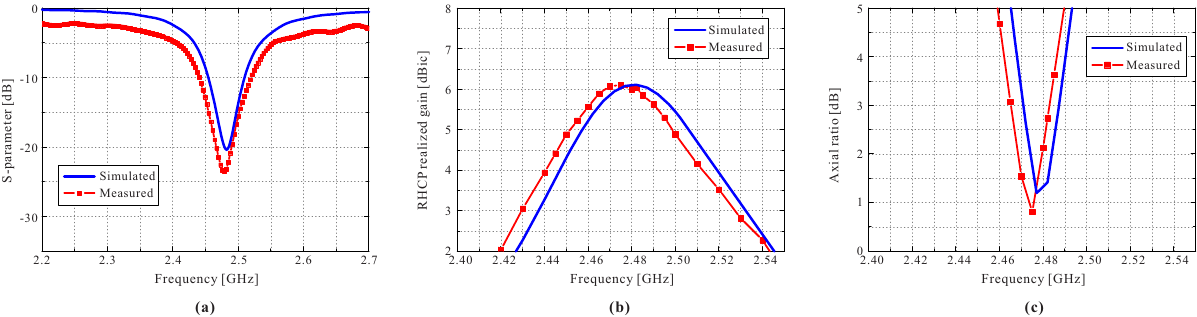
Figure 10. Simulated and measured results of the 2.4 GHz patch antenna: ( a ) reflection coefficients; ( b ) realized gain; ( c ) axial ratio.